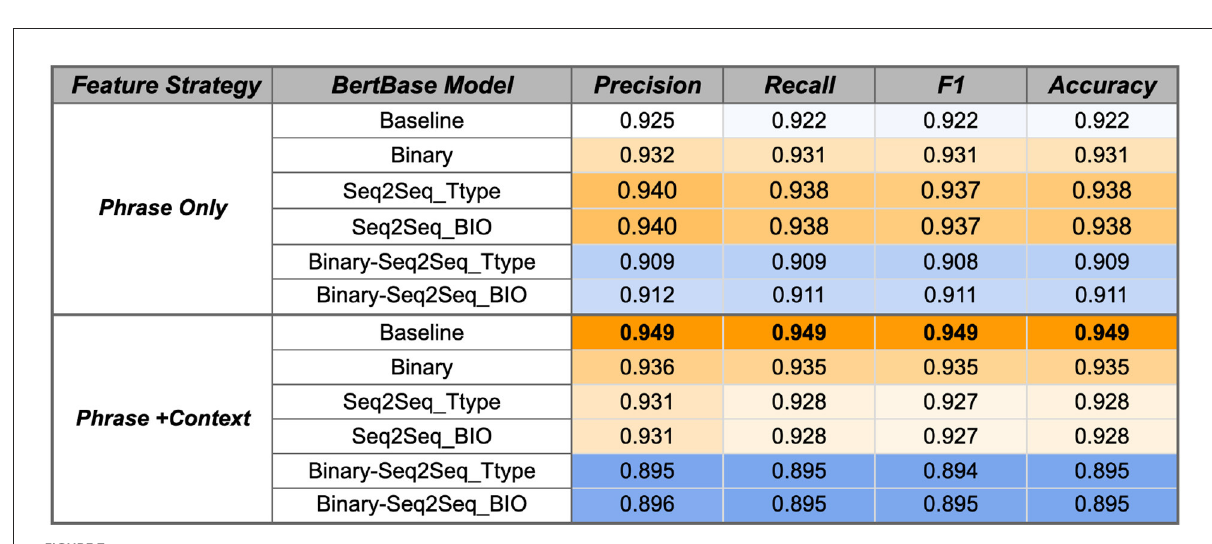
relative to all scores in the table.